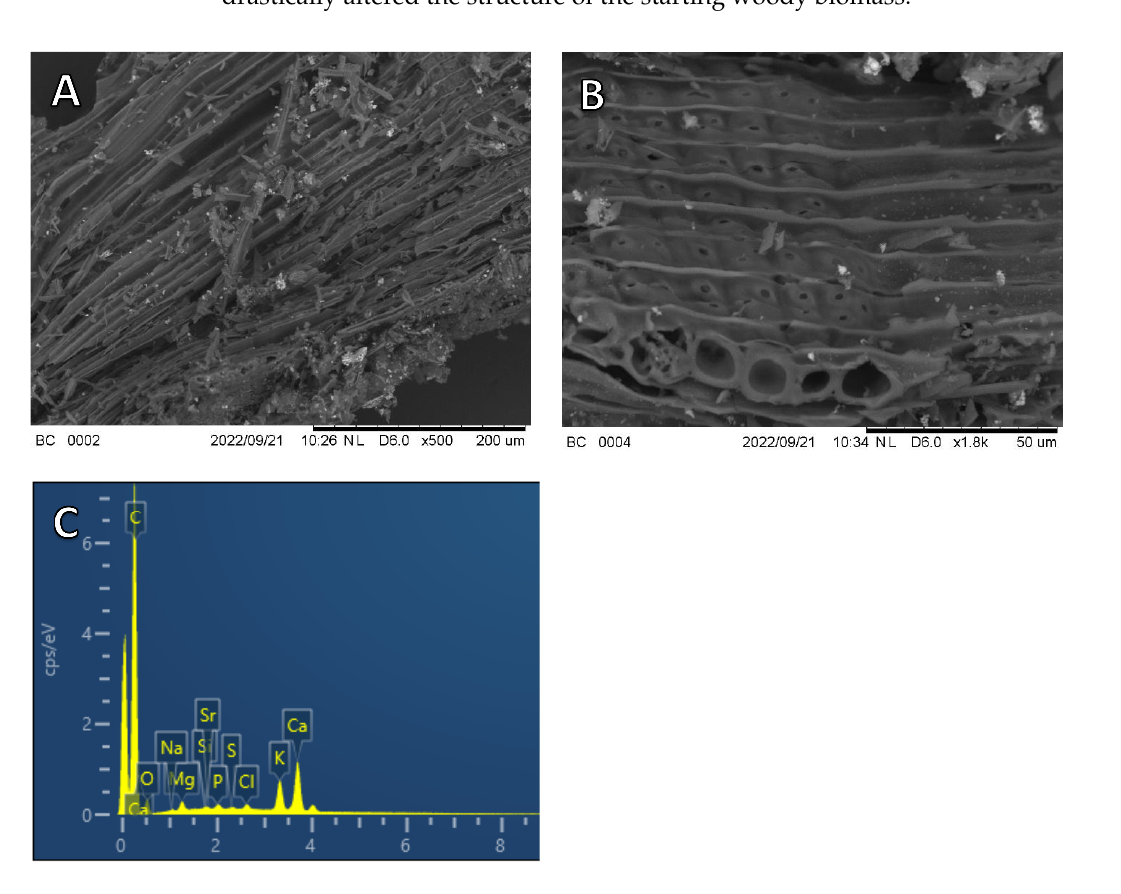
Figure 2. Scanning electron microscopy (SEM) images at magnifications of 500 ( A ) and 1800 ( B ) and energy-dispersive X-ray (EDX) spectrum ( C ) of biochar. Images were taken with secondary elec- trons.